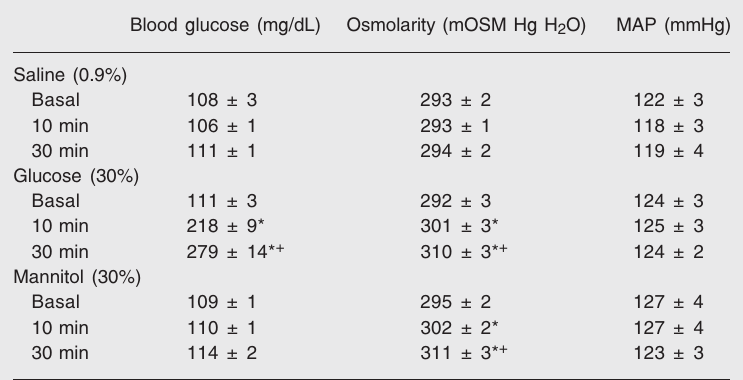
Data are reported as means ± SEM for 14 rats in each group. *P < 0.05 compared to basal levels. + P < 0.05 compared to 10 min of infusion (two-way analysis of variance for repeated measures, followed by the post hoc Tukey